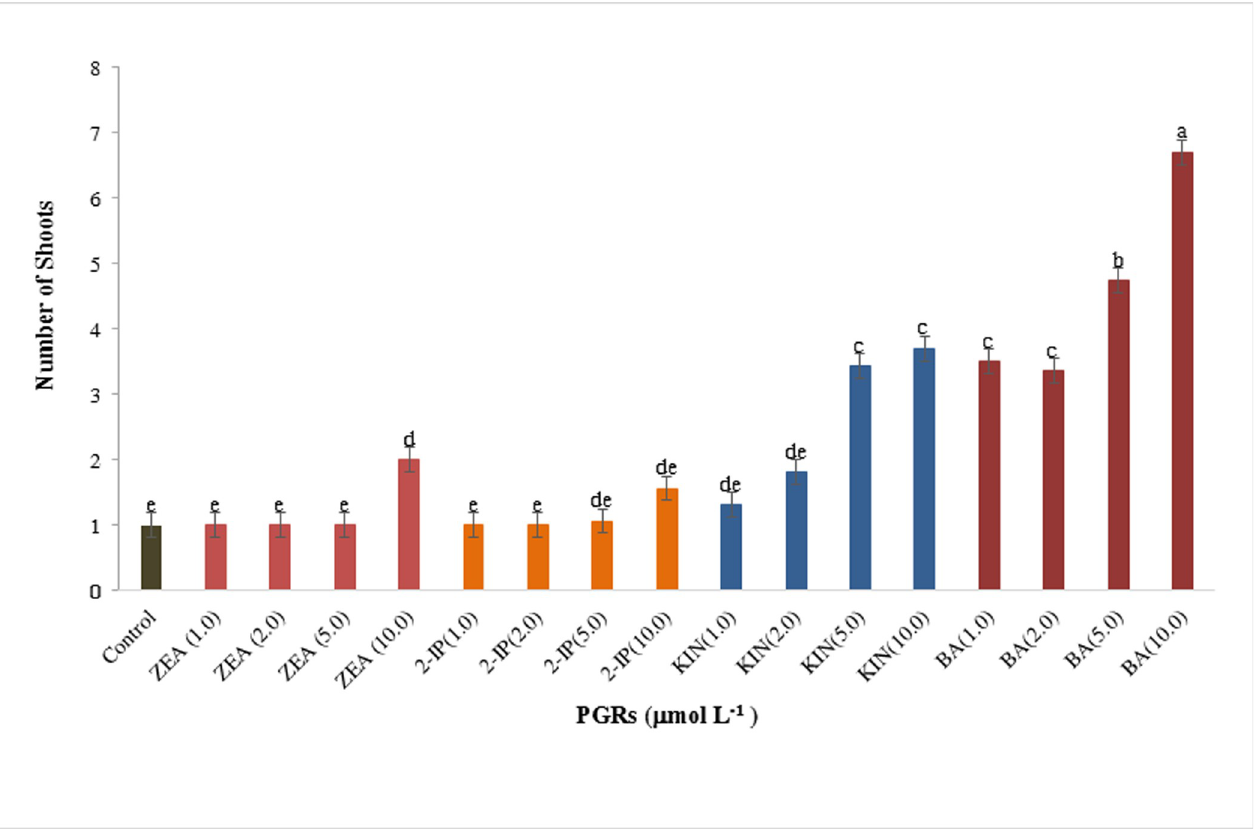
Fig 3. The effects of four cytokinins, zeatin (ZEA), 2-isopentenyladenine (2-IP), kinetin (KIN) and 6-benzylaminopurine (BA) on numbers of shoot after 5 weeks of culture. Bars represent means ± standard error, where means followed by the different letters are significantly different according to Tukey-Kramer HSD test. Each level consisted of five biological